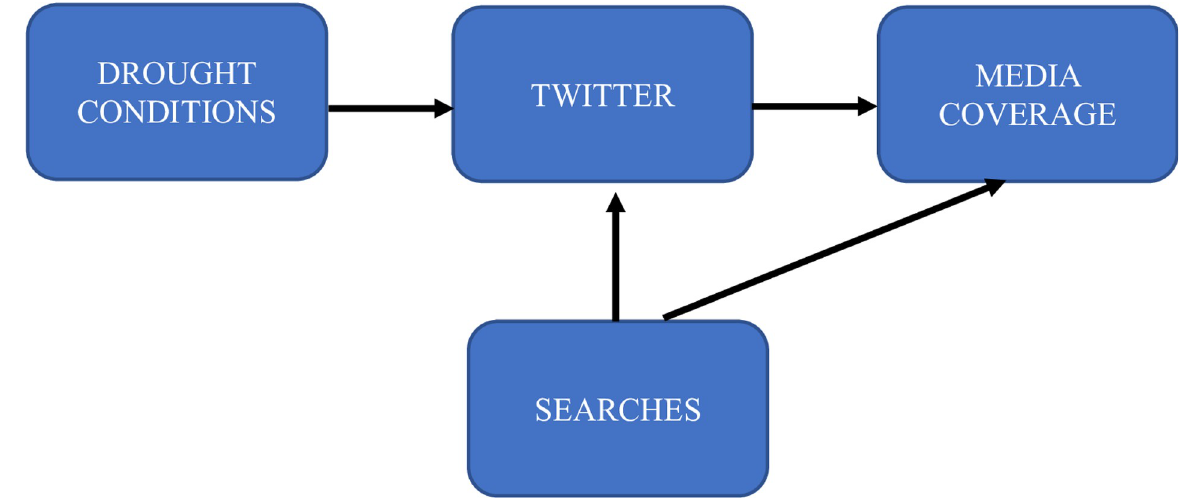
Fig 2. Theory-based presumptive interactions between communicative factors during the California